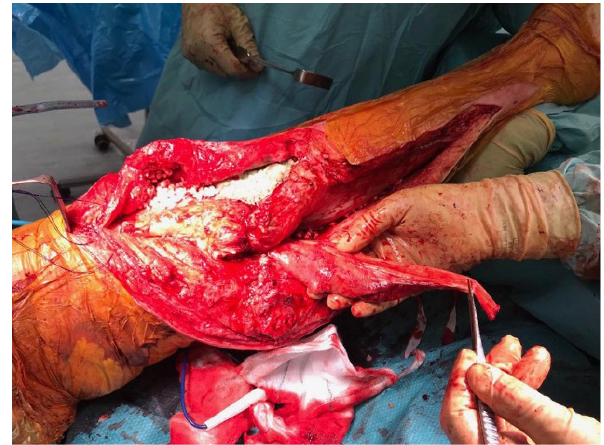
Figure 2. Medial gastrocnemius flap